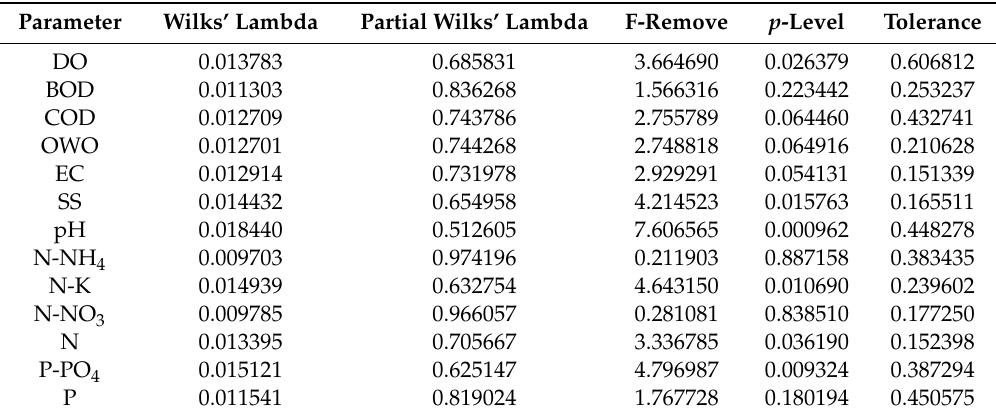
Table 5. The discriminant analysis of water quality parameters measured at 10 stations, variable grouping—season.